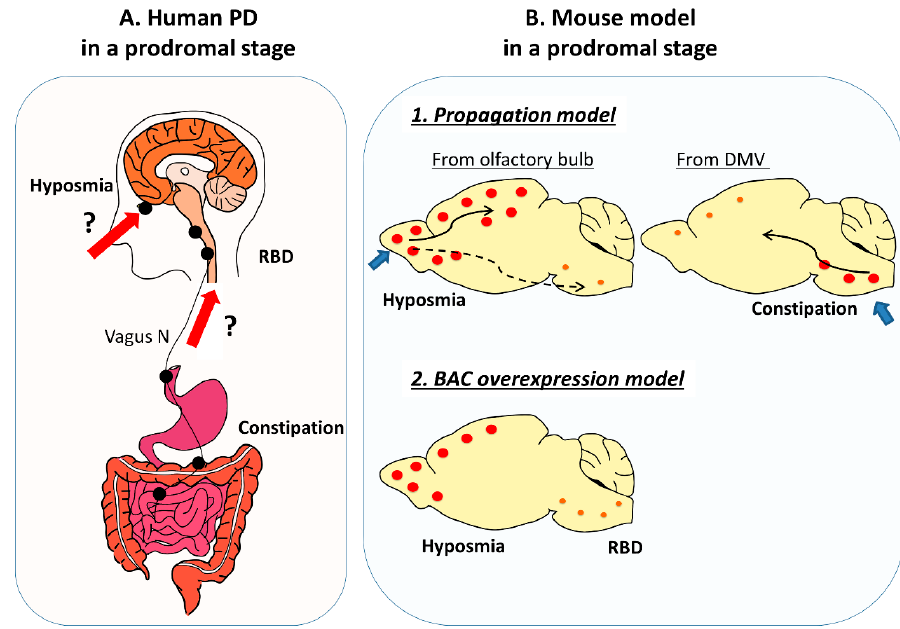
Figure 1. Human Parkinson’s disease (PD) and mouse model in a prodromal stage. ( A ) In human PD, Lewy pathology is already present in a prodromal stage in extra central nervous system (CNS) tissues including GI tract and autonomic nerves, and in the lower brainstem and / or olfactory bulb. As a prodromal symptom hyposmia, constipation, and rapid eye movement sleep behavior disorder (RBD) appear in a chronologically close period, suggestive of the multifocal initiation of PD. Black dots indicate Lewy pathology. Bold red arrows and question marks indicates hypothesized propagation pathway of Lewy pathology in human. ( B ) In a propagation model, α -syn aggregates start from the olfactory bulb or the GI tract / dorsal nucleus of the vagus nerve (DMV), and hyposmia and GI dysfunction appear as its corresponding symptoms in a prodromal stage. In contrast, in a α -syn BAC transgenic model that mildly overexpresses α -syn in its native expression manner, both of hyposmia and RBD are observed with multifocal accumulation of phosphorylated α -syn. Orange dots indicate accumulateon of phosphorylated α -syn and bold blue arrows indicate entry zone of injected α -syn. Thin solid arrows shows main propagateon pathway of α -syn and dotted arrows indicate minor propagateon pathway in animal experiments.